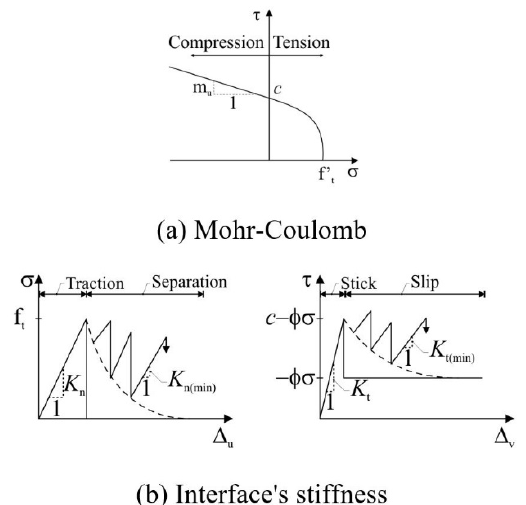
Figure 7. Constitutive model of interface element. Adapted from Gholamhoseini [28]